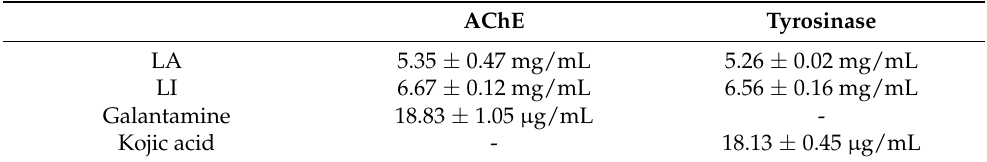
Table 4. Acetylcholinesterase (AChE) and tyrosinase inhibition activities of L. angustifolia (LA) and L. × intermedia extracts, and reference inhibitors galantamine and kojic acid. The results are expressed as the mean ± standard deviation of IC50 values. The results were obtained from three independent experiments on the replicates of the